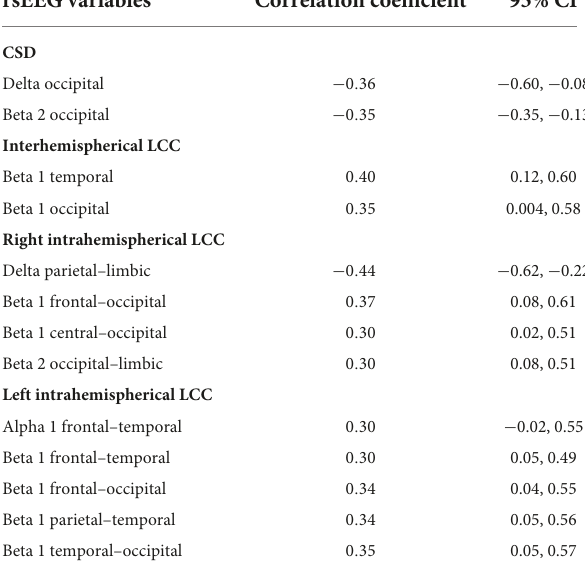
TABLE 2 Pearson’s correlation coefficients and 95% confident intervals for moderate effect sizes of correlation between CRI and rsEEG